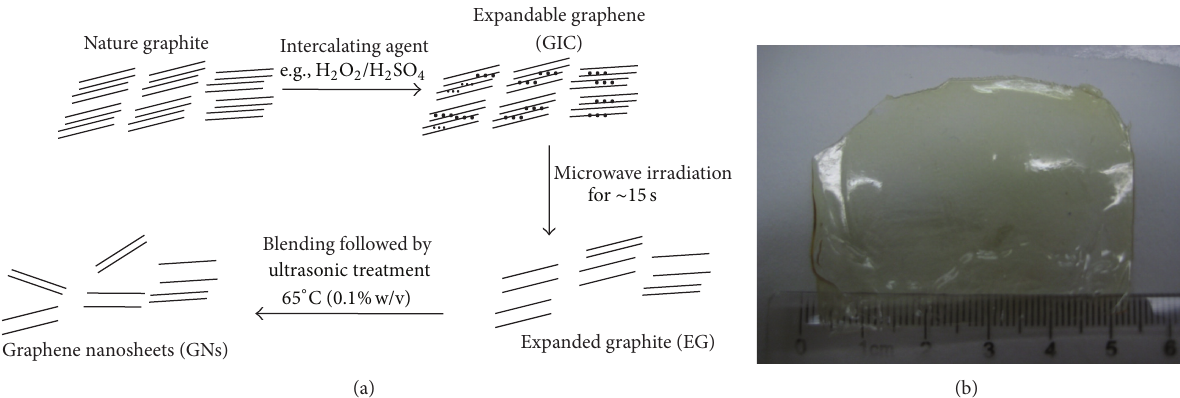
Figure 2: A schematic illustration of the preparation of graphene nanosheets (GNs) from natural graphene (a) and the photo of resultant 10% biocide thin film